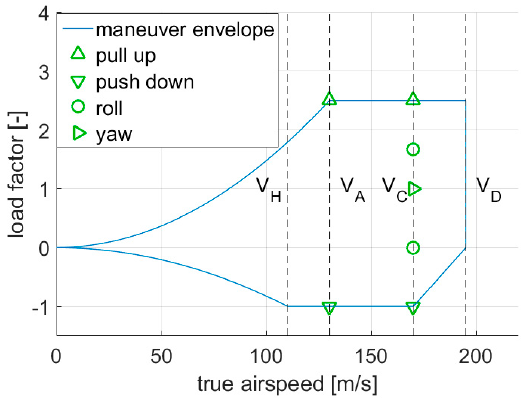
Figure 16. Considered maneuver cases in an exemplary V-n diagram.